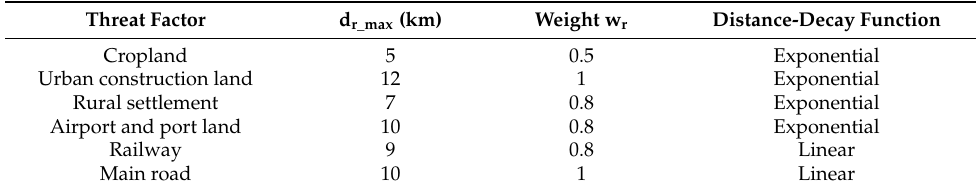
Table 3. The threat factors and related